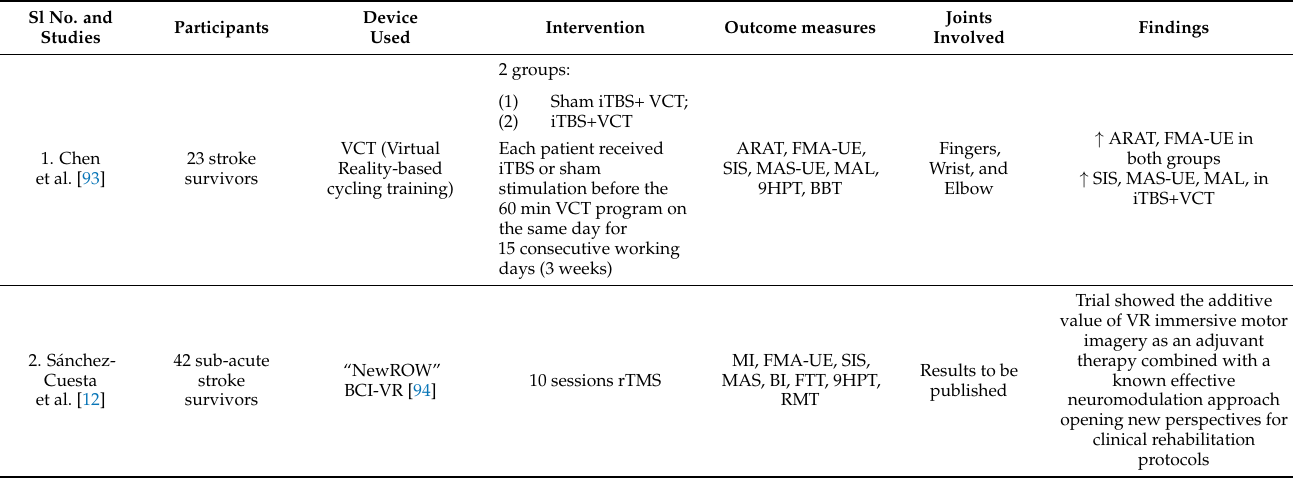
Table 3. Combined VR and rTMS studies primarily focusing on distal upper